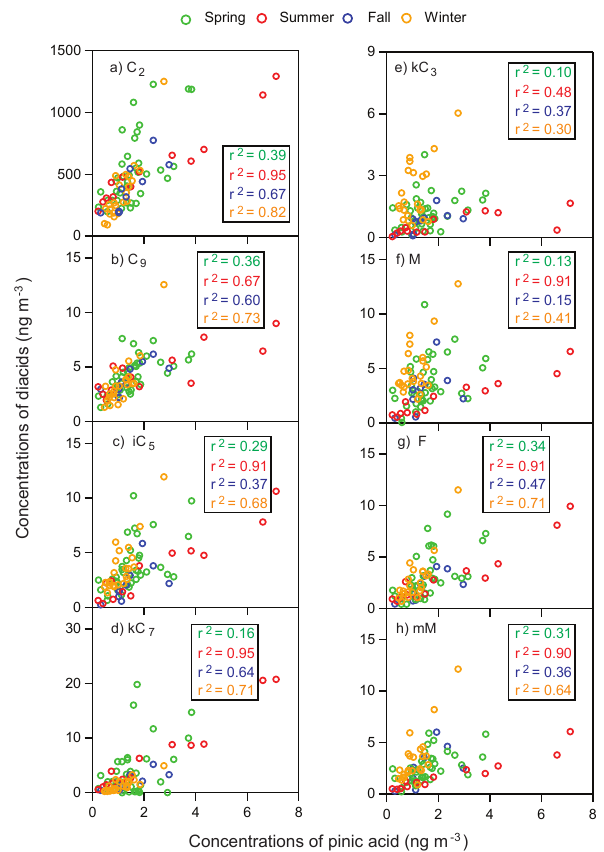
Figure 6. Correlations of pinic acid (a SOA tracer of α -pinene) with saturated (a – e) and unsaturated (f – h) diacids in aerosol samples col- lected from April 2003 to April 2004: (a) oxalic (C 2 ) , (b) azelaic (C 9 ) , (c) methylsuccinic (iC 5 ) , (d) ketopimelic (kC 7 ) , (e) ketoma- lonic (kC 3 ) , (f) maleic (M), (g) fumaric (F) and (h) methylmaleic (mM) acids. Note that data have been grouped according to the sea-